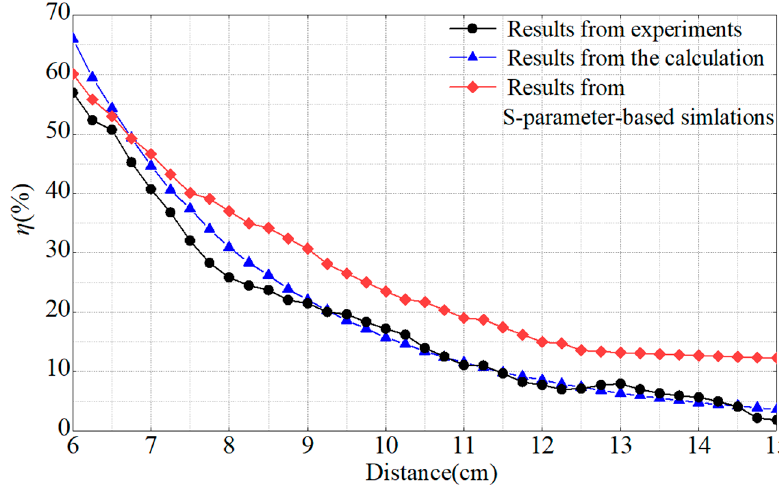
Figure 13. Comparison of different efficiency results after adding MTM slab in a WPT system.